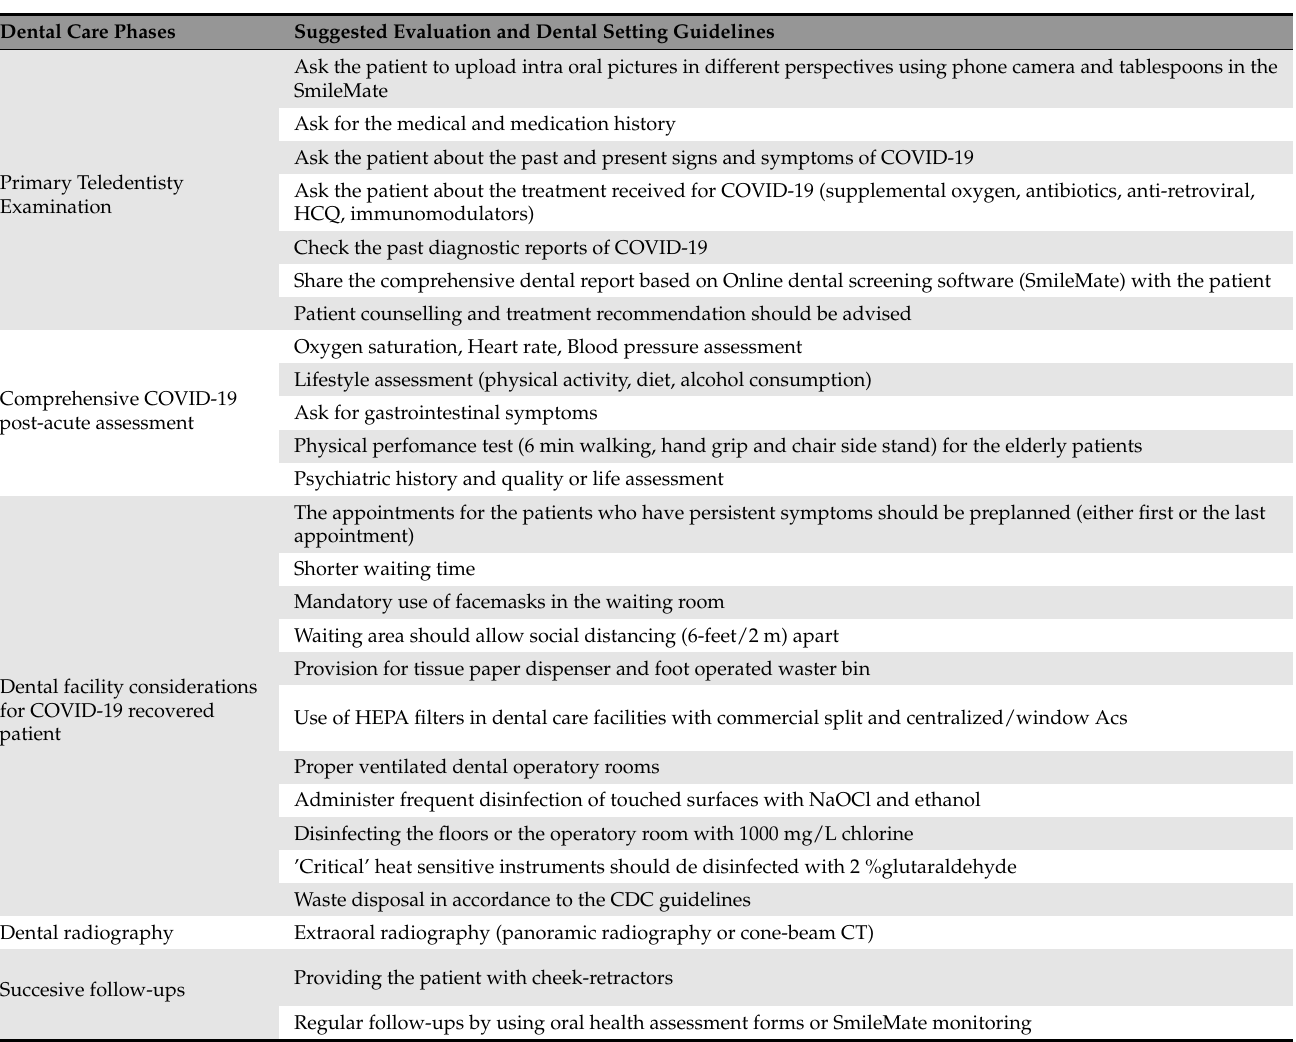
Table 3. Suggested health assessments and dental setting guidelines for the treatment of COVID-19 patients. Dental Care Phases